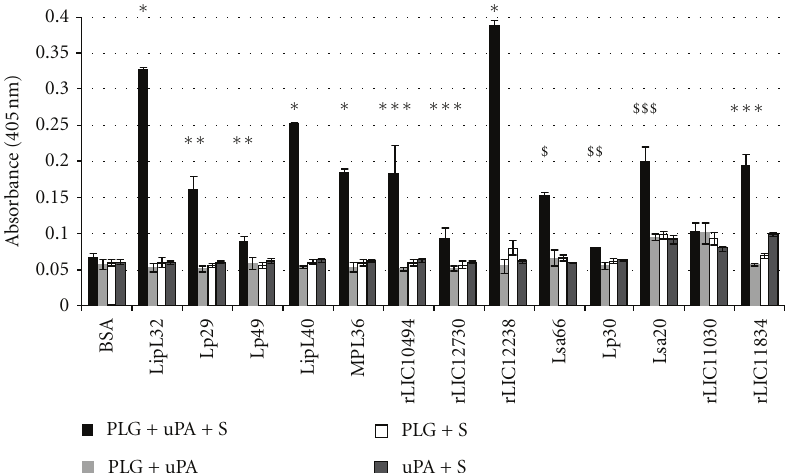
Figure 7: Activation of recombinant protein-PLG to enzymatically active plasmin. Cleavage of specific plasmin substrate by PLG bound to recombinant proteins was assayed by modified ELISA as immobilized proteins received the following treatment: PLG + uPA + specific plasmin substrate (PLG + uPA + S) or controls lacking one of the three components (PLG + uPA; PLG + S; uPA + S). BSA was employed as a negative control. Bars represent the mean absorbance values at 405nm, as a measure of relative substrate cleavage, ± the standard deviation of four replicates for each experimental group and are representative of two independent experiments. Statistically significant di ff erences are shown by ∗ ( P < 0.00001), ∗∗ ( P < 0.005), ∗∗∗ ( P < 0.05), $ ( P < 0.001), $$ ( P < 0.02), and $$$ ( P <